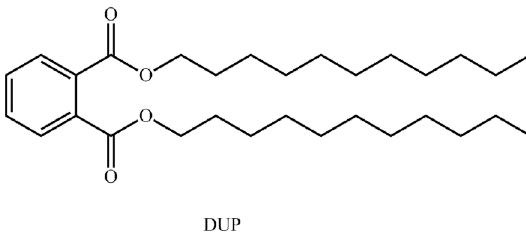
Figure 1. Molecular structure of the template molecule diundecyl phthalate (DUP).